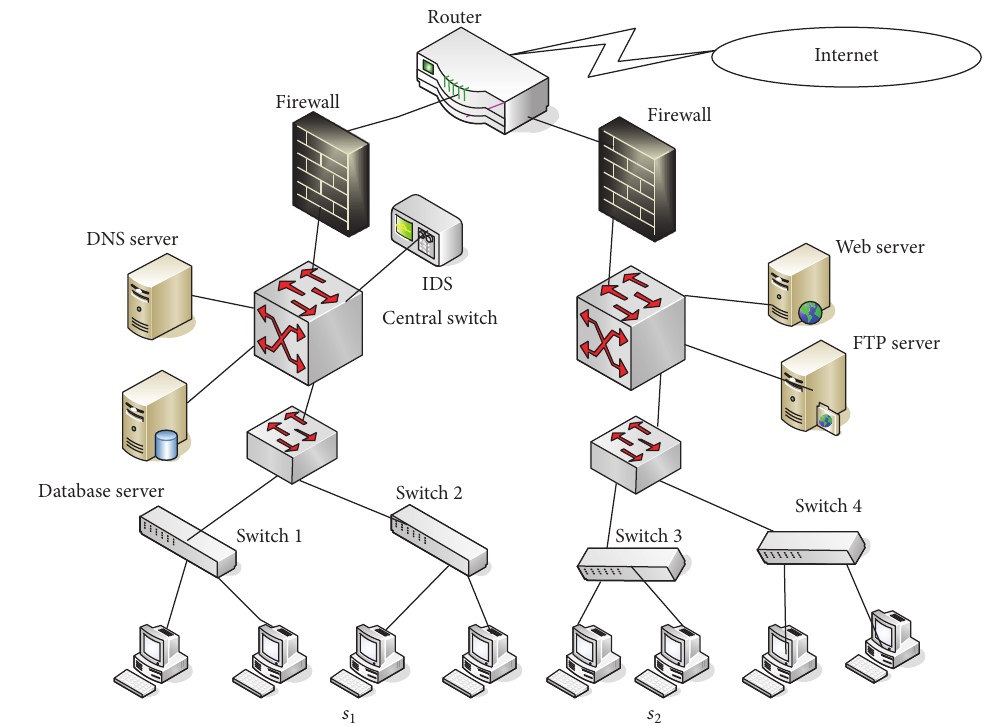
Figure 3: The experimental environment structure diagram.